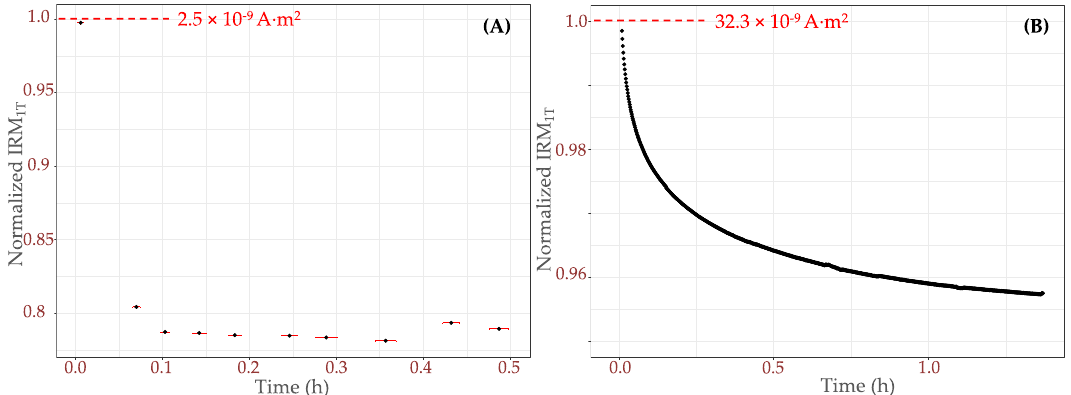
Figure A1. Normalized IRM 1T variations over the time for ( A ) sample holder and ( B ) holder filled with samples, illustrating the weak viscous effect due to the presence of iron-oxide impurities in the plastic molding such as superparamagnetic or a multi-domain like behavior particles.